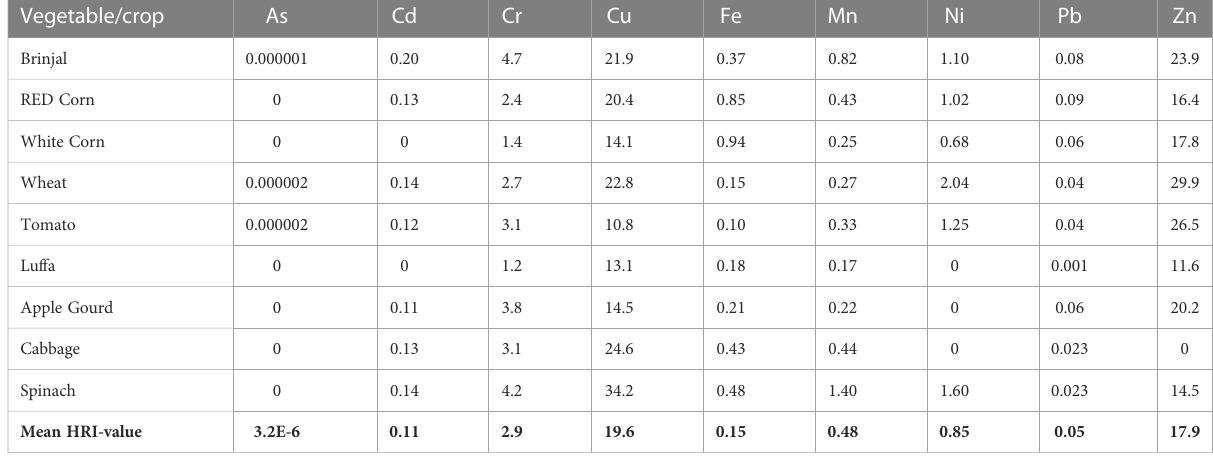
TABLE 5 Assessment of health risk index (HRI) of metals upon consumption of contaminated vegetable/crop food. Vegetable/crop Brinjal White Corn Wheat Tomato Apple Gourd Cabbage